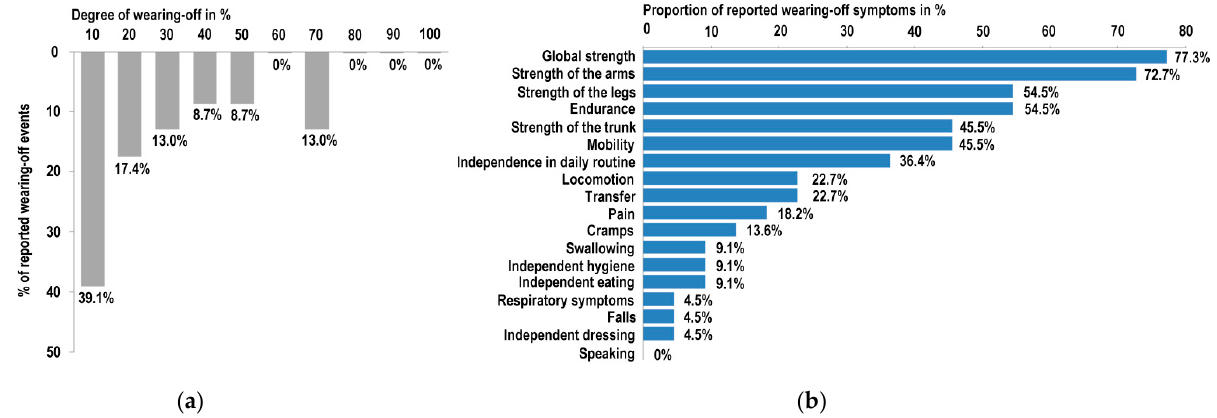
Figure 2. Quantitative and qualitative wearing-off effects subsequent to 51 nusinersen administrations. ( a ) In 23 (45.1%) of 51 nusinersen administrations, a decline in treatment effects was stated. The bar chart illustrates the degree of wearing- off symptoms between 10% and 100% compared to the individual condition after the last received nusinersen dosing. Predominantly, a mild wearing-off (10%) was reported, followed by 20% and 30% in 17.4% and 13.0% of cases, respectively. Rarely, a more severe deterioration (70%) was perceived. ( b ) Distribution of specific symptoms and functions affected by wearing-off. Strength, namely muscle function of the arms more than of the legs, endurance, mobility and independence in daily routine were mainly indicated to be affected by nusinersen wearing-off. Occurrences of pain and cramps were reported in 18.2% and 13.6%, respectively. Bulbar function (swallowing (9.1%) and speaking (0%)) does not seem to wane in between nusinersen administrations.